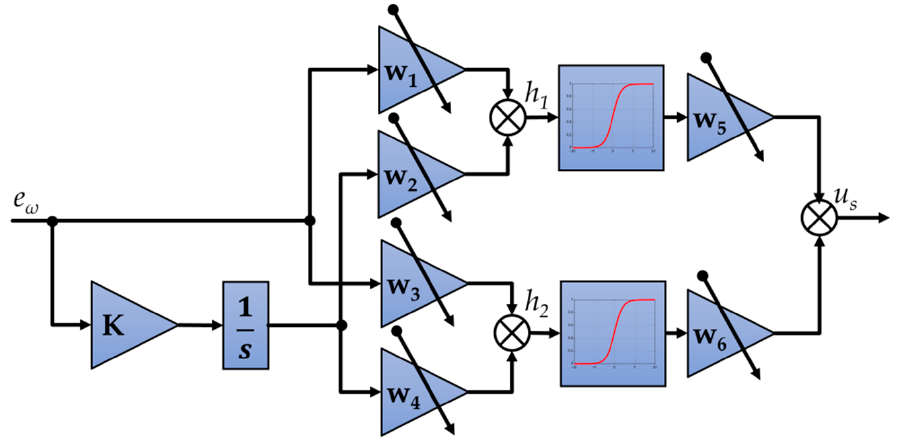
Figure 9. Structure of neural adaptive speed controller.